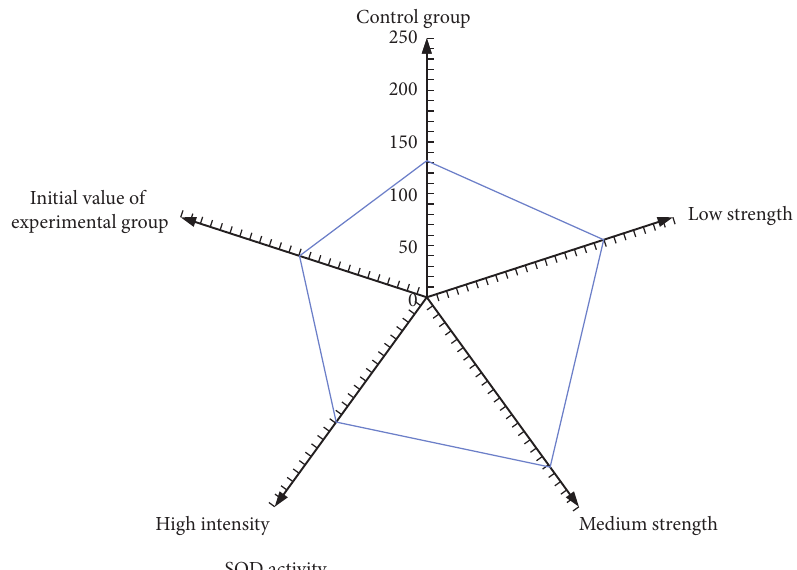
Figure 1: Statistical analysis of the effect of different exercise intensities on SOD activity in each group.